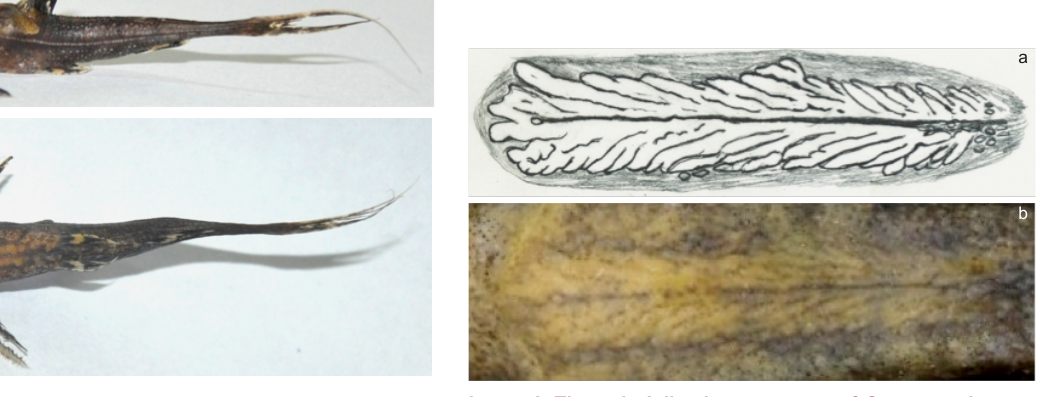
Image 2. Thoracic Adhesive apparatus of Conta pectinata , length: